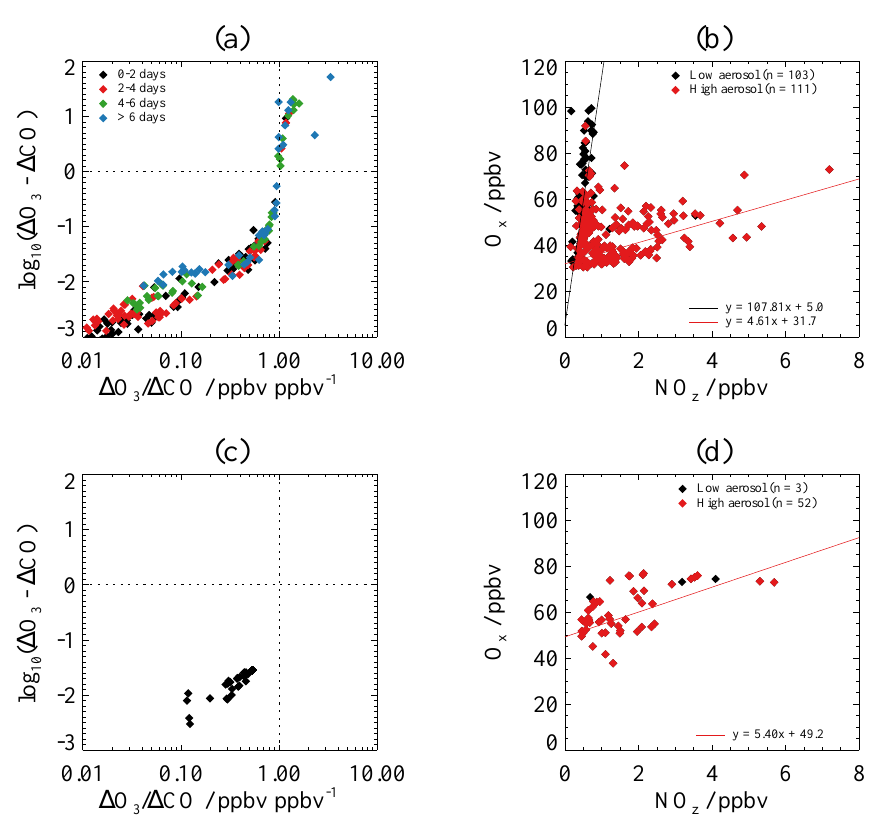
Fig. 13. Relationships between (a) 1 O 3 and 1 CO, following Fig. 7, and (b) O x and NO z , following Fig. 8b, from aircraft measurements made in biomass burning plumes during ARCTAS-B in the summer of 2008, and (c) 1 O 3 and 1 CO and (d) O x and NO z from aircraft measurements made in biomass burning plumes during ABLE 3B in the summer of 1990.